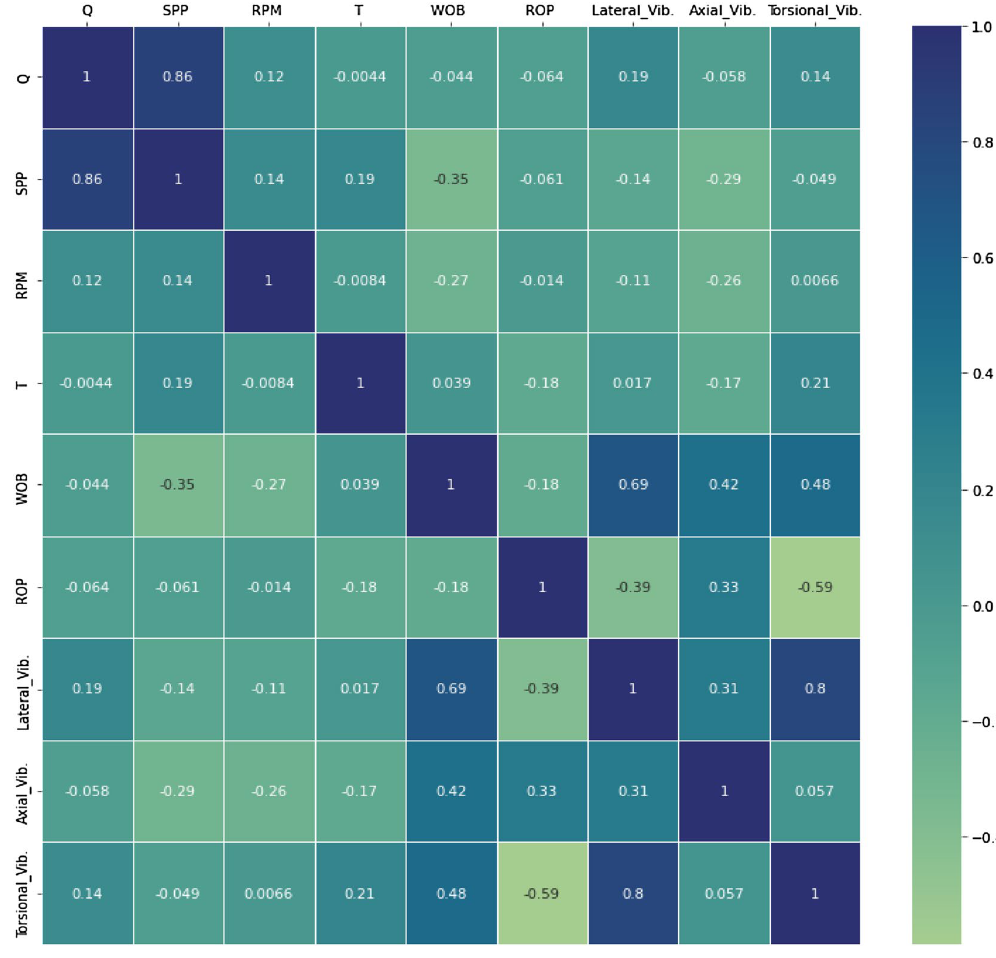
Figure 4. Data heat map (generated by Python https:// www. python.